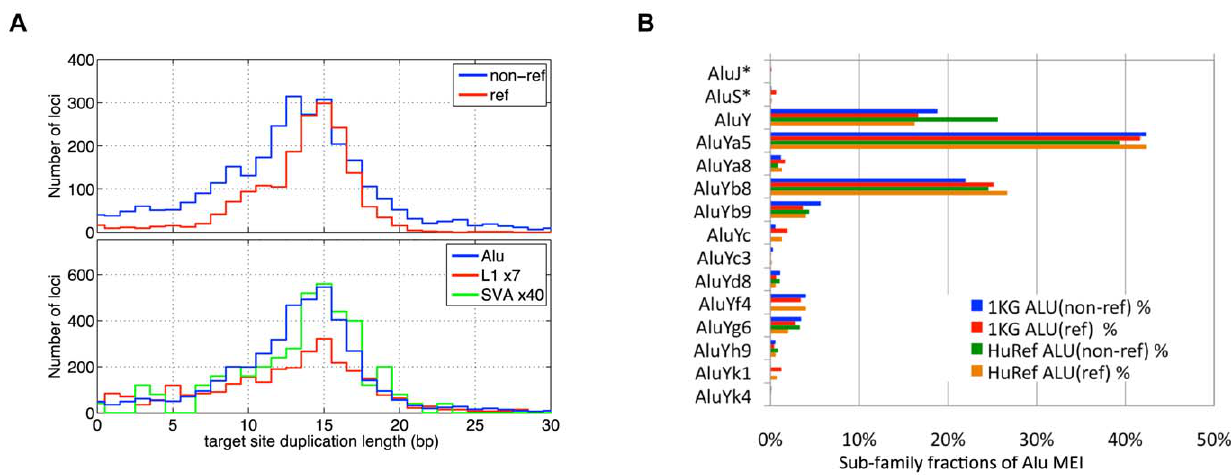
Figure 4. MEI Alu sub-family breakdown, Target site duplication length. a) Length of target site duplications bracketing the MEI sites. Different detection modes (top) and different element families (lower plot) exhibit similar distributions target site duplications lengths. b) Alu sub- family breakdown of 1,105 assembled Alu non-reference insertions. Also shown are the Alu breakdowns from reference MEI (ref) from this study, as well as variant Alus found in the HuRef genome by Xing et al. AluYa5 is the most frequent polymorphic Alu